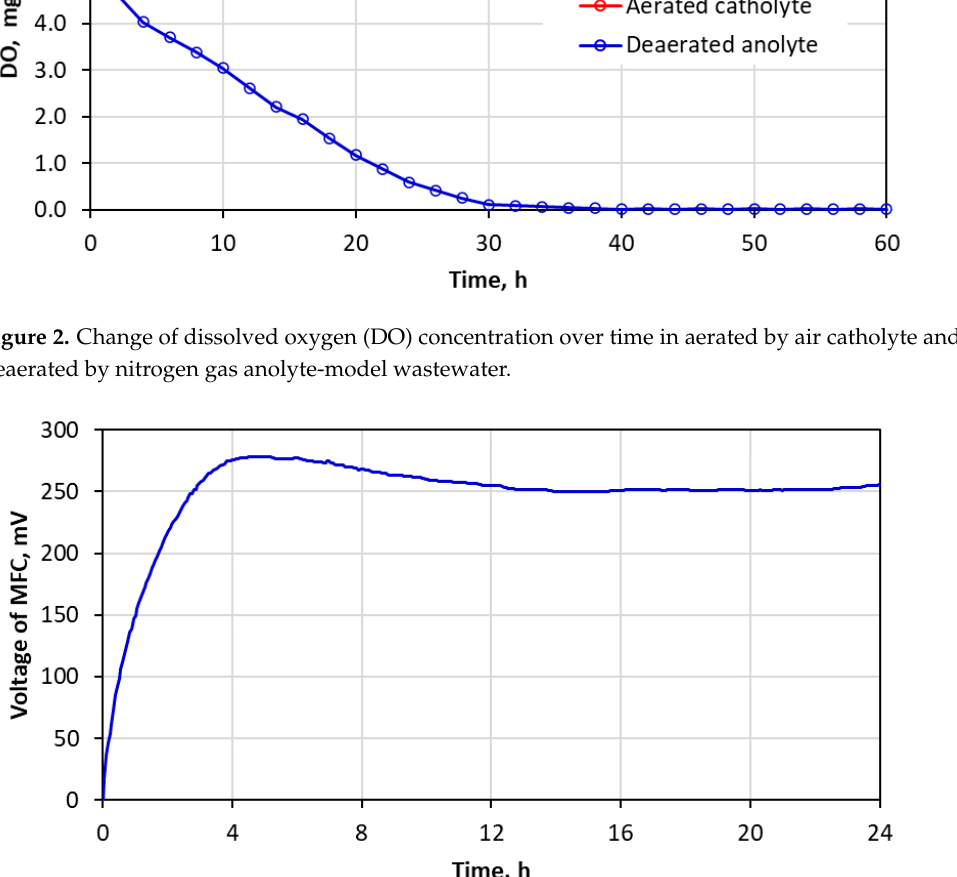
Figure 2. Change of dissolved oxygen (DO) concentration over time in aerated by air catholyte and deaerated by nitrogen gas anolyte-model wastewater.